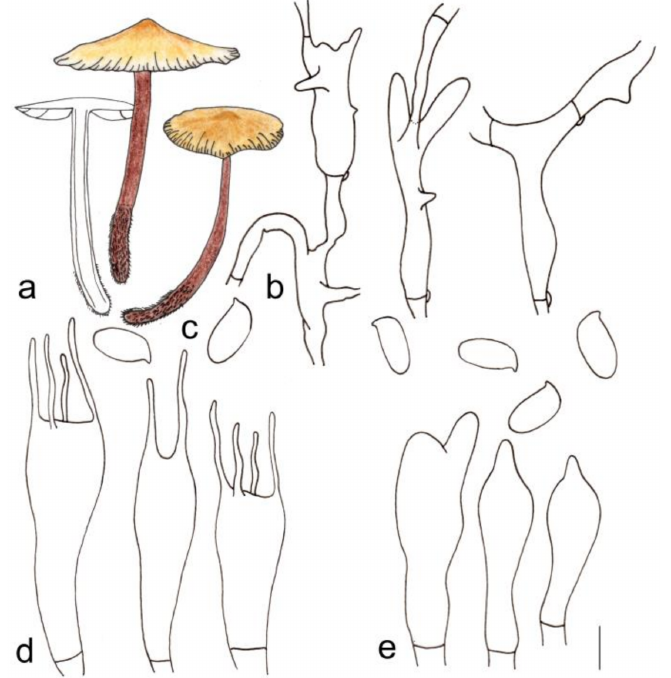
Figure 6. Morphological characteristics of Gymnopus macrosporus (HMJAU 60294, holotype): ( a ) basidiomata, ( b ) pileipellis, ( c ) basidiospores, ( d ) basidia, and ( e ) cheilocystidia. Scale bars: 1 cm ( a ), 25 µ m ( b ), and 5 µ m ( c – e